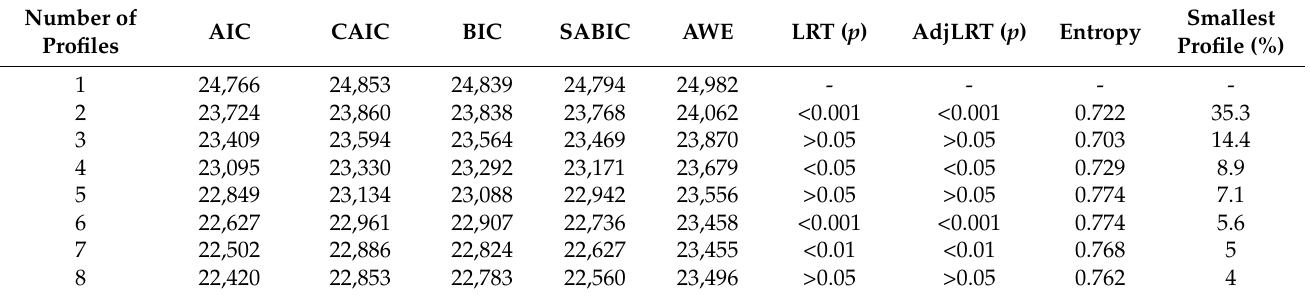
Table 2. Fit indices for the eight estimated solutions of job demand and resource profiles.